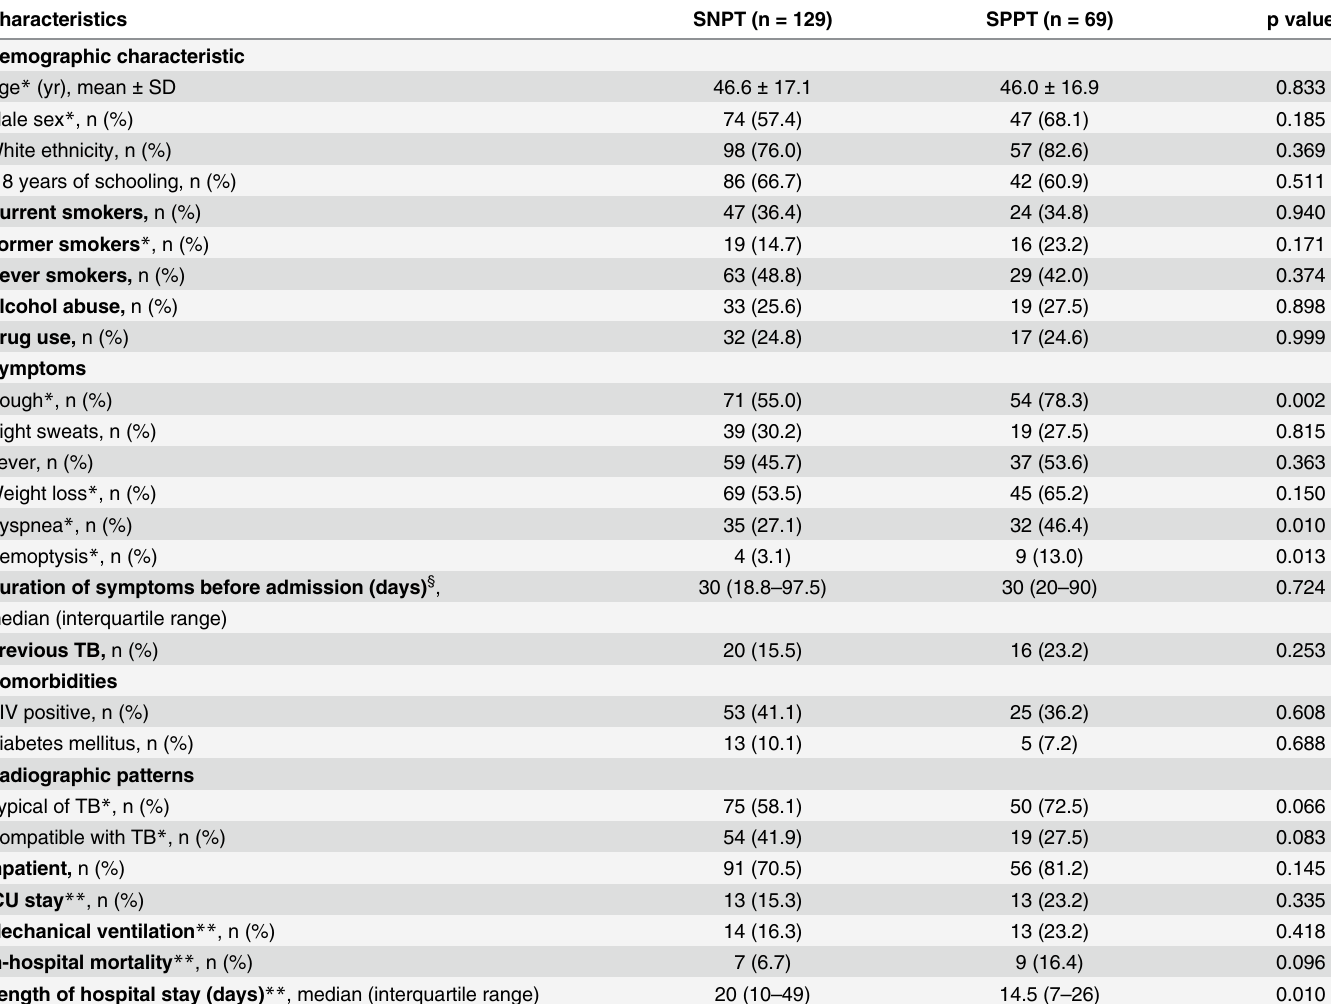
Table 1. Characteristics of patients with SNPT and